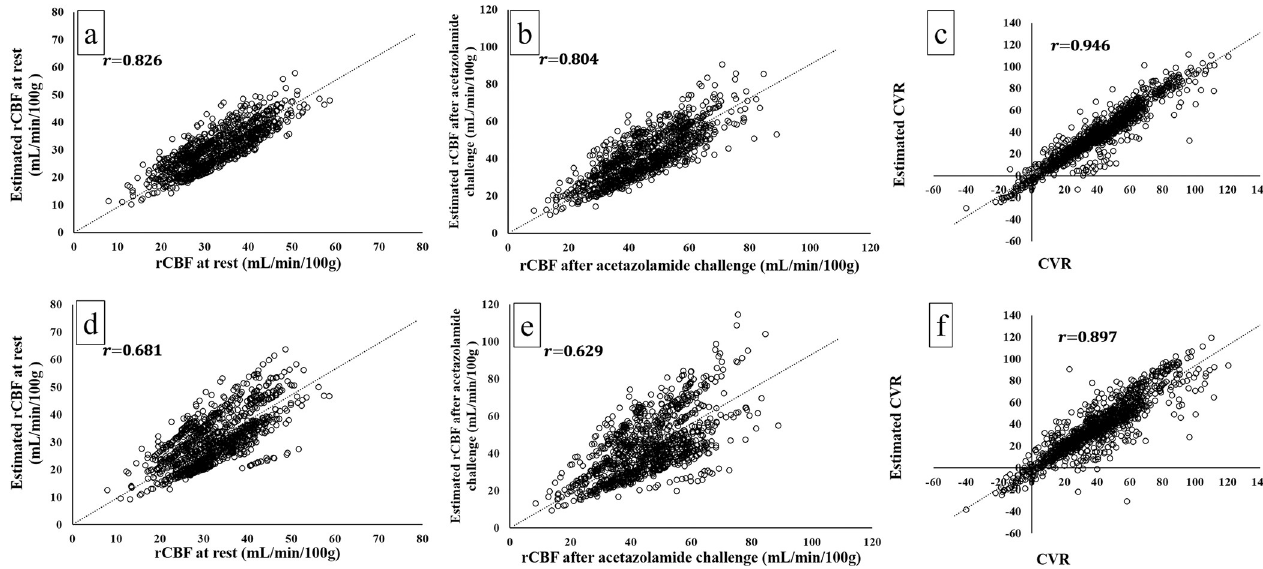
Fig 6. Scatterplot with regression line between the true measured and estimated rCBF at rest (a) by our proposed model revealed Pearson’s r-value of 0.83 and (d) by conventional method revealed Pearson’s r-value of 0.68. Scatterplot with regression line between the true measured and estimated rCBF after acetazolamide challenge (b) by our proposed model revealed Pearson’s r-value of 0.80 and (e) by conventional method revealed Pearson’s r-value of 0.63. Scatterplot with regression line between the true measured and estimated CVR (c) by our proposed model revealed Pearson’s r-value of 0.95 and (f) by conventional method revealed Pearson’s r-value of